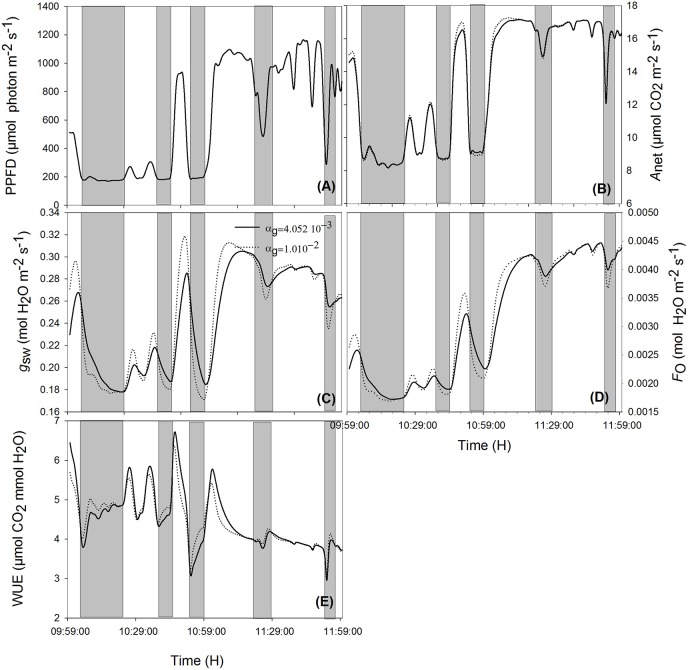
Effect of varying time constant for stomata response (αg) on net assimilation rate (B), stomatal conductance (C), transpiration rate (D), water use efficiency (E) for different photosynthetic active radiation (PAR; A) during the sunny day. Simulations were performed in steps of 1 s over 2 h (from 10:00 a.m. to 12:00 p.m.) and are extracted from measurements over 2 days data. Solid lines represent the fastest stomata opening/closing (αg=4.052·10-3) and dotted lines represent the simulation result for αg=1.01·10-2. Highlighted areas correspond to time courses where slower reacting stomata have a better water use efficiency. Other climatic data were extracted from the 2 days measurement data presented in Figure 1, and all other parameter values are defined in Tables 1, 2.